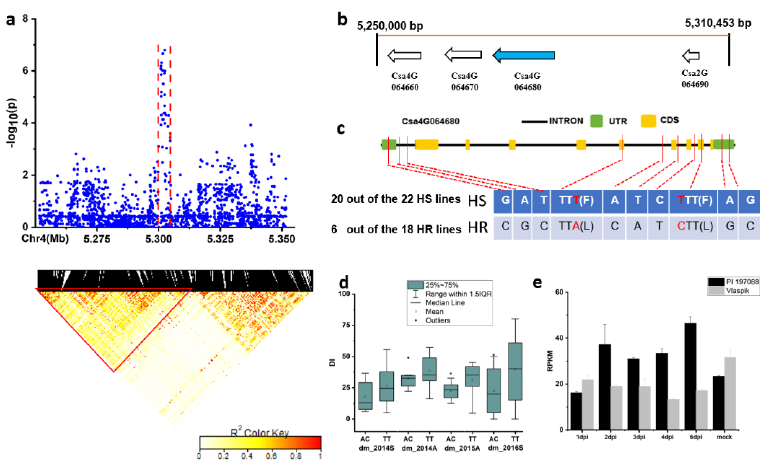
Figure 9. Identification of the causal gene for the locus dmG4.1 . ( a ) Local Manhattan plot (top) and LD heatmap (bottom) surrounding the peak of dmG4.1 ; ( b ) four genes predicted in the LD block region. ( c ) SNP variation of the candidate gene Csa4G064680 between the highly susceptible (HS) and highly resistant (HR) lines (see Supplementary File 5). The two SNPs in red color are located in the CDS, resulting in amino acid variation. ( d ) Disease index (DI) comparison between haplotypes of the HS and HR lines (see Supplementary file 3); ( e ) RPKM of the candidate gene Csa4G064680 based on the transcriptome of PRJNA285071 (data obtained from http://cucurbitgenomics.org/rnaseq/cu/19) [24]. * indicates significance at p < 0.05.